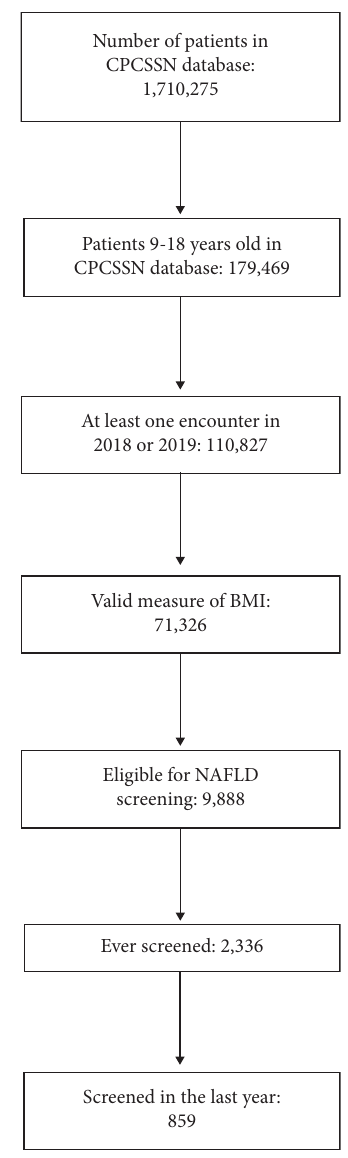
Figure 1: Selection of study